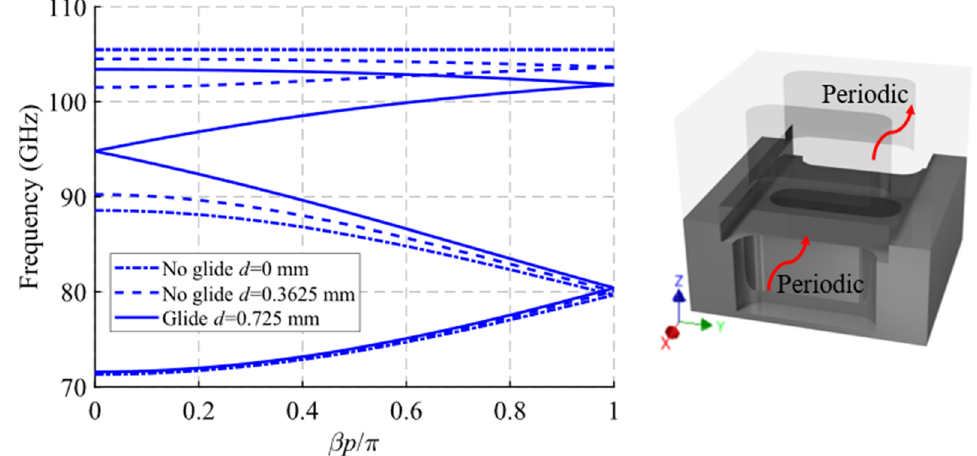
Figure 18. Dispersion diagram of the double periodic ideal unit cell for different stages of break of symmetry. Glide-symmetric for d = 0.725 mm and non-glide-symmetric for lower values. D = 0 mm for a maximum break of the symmetry.